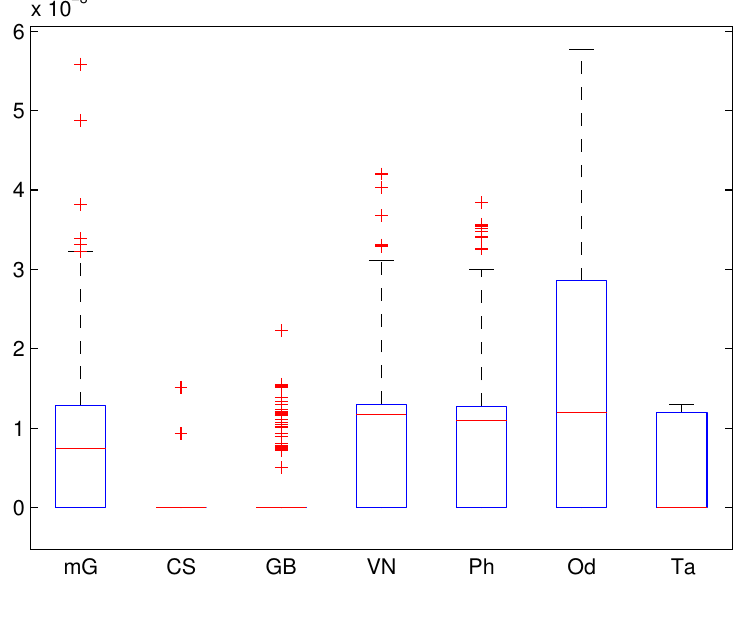
Figure 4: Box plot of the CSL